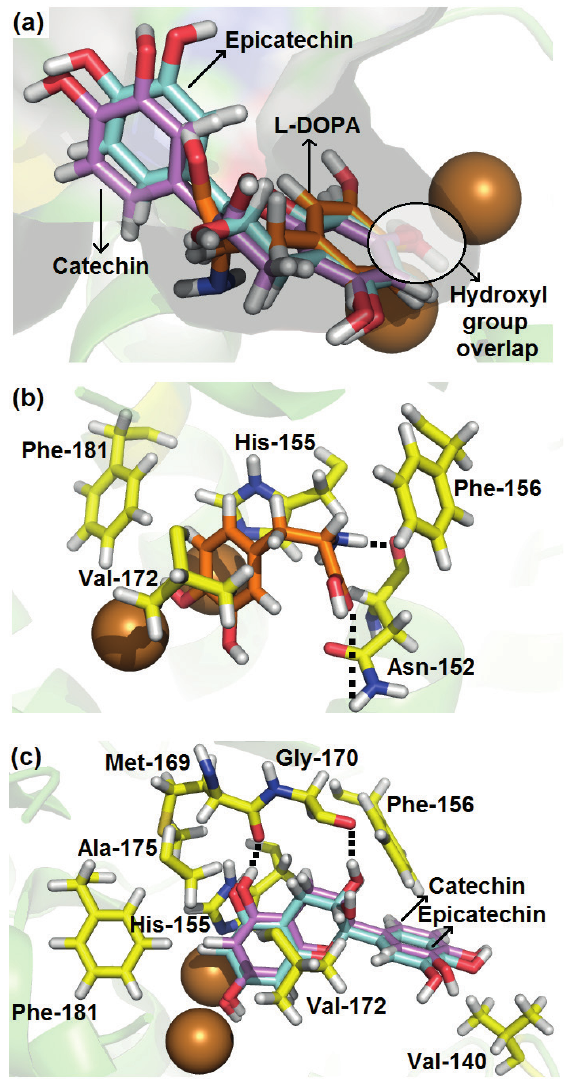
Figure 5. (a) Overlap between three potential tyrosinase activators interacting with Cu (II) ions. (b) Best score pose for tyrosinase:L-DOPA. (c) Overlap between the best score pose for tyrosinase:catechin/ epi catechin. Selected amino acids residues, L-DOPA, catechin and epi catechin are represented as sticks in yellow, orange, violet and cyan, respectively. Copper ions (Cu (II) are represented as spheres in brown. Black dots represent interaction via hydrogen bonding. Hydrogen: white; oxygen: red; nitrogen: dark blue, and sulfur: